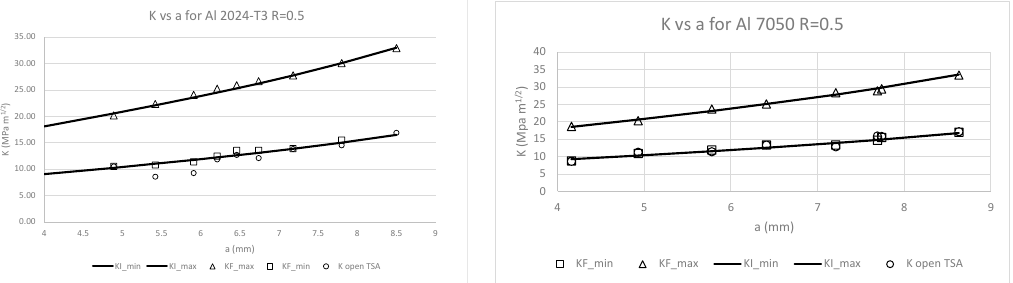
Figure 4. Comparison of experimental and nominal K values at different crack lengths for Al7050-T6 and Al2024-T3 at R = 0.5.